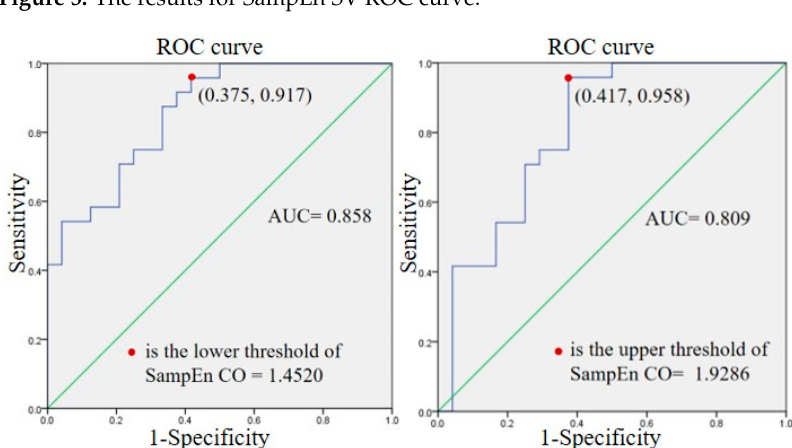
Figure 6. The results for SampEn CO ROC curve.